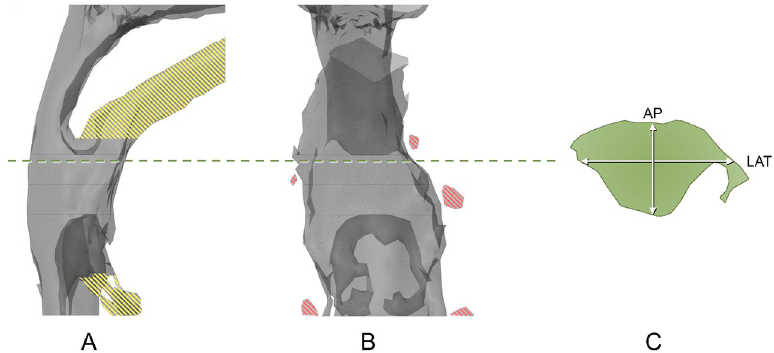
Fig 2. Measurement of minimum cross-sectional area (MCA), using Blender software. (A) “Dead space” (yellow shadow) of the evaluated airway. (B) “Islands” (red shadow) of the evaluated airway. (C) Anteroposterior dimension (AP) and lateral dimension (LAT) of